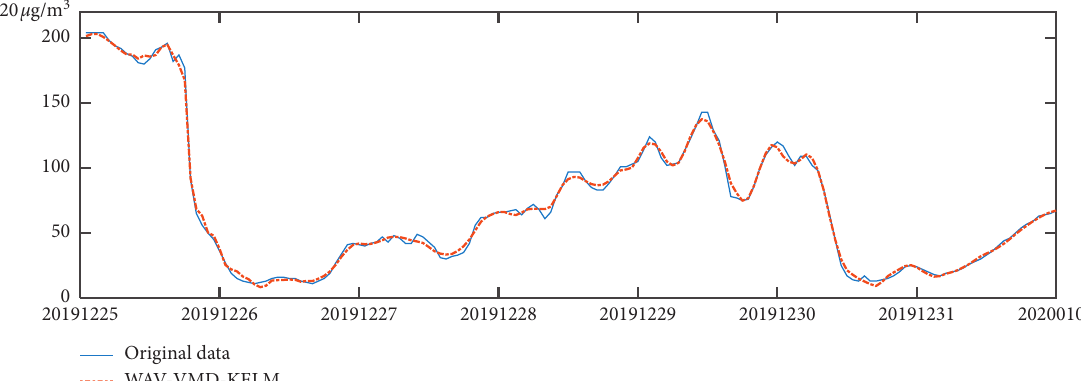
Figure 11: Forecasting curve of the PM